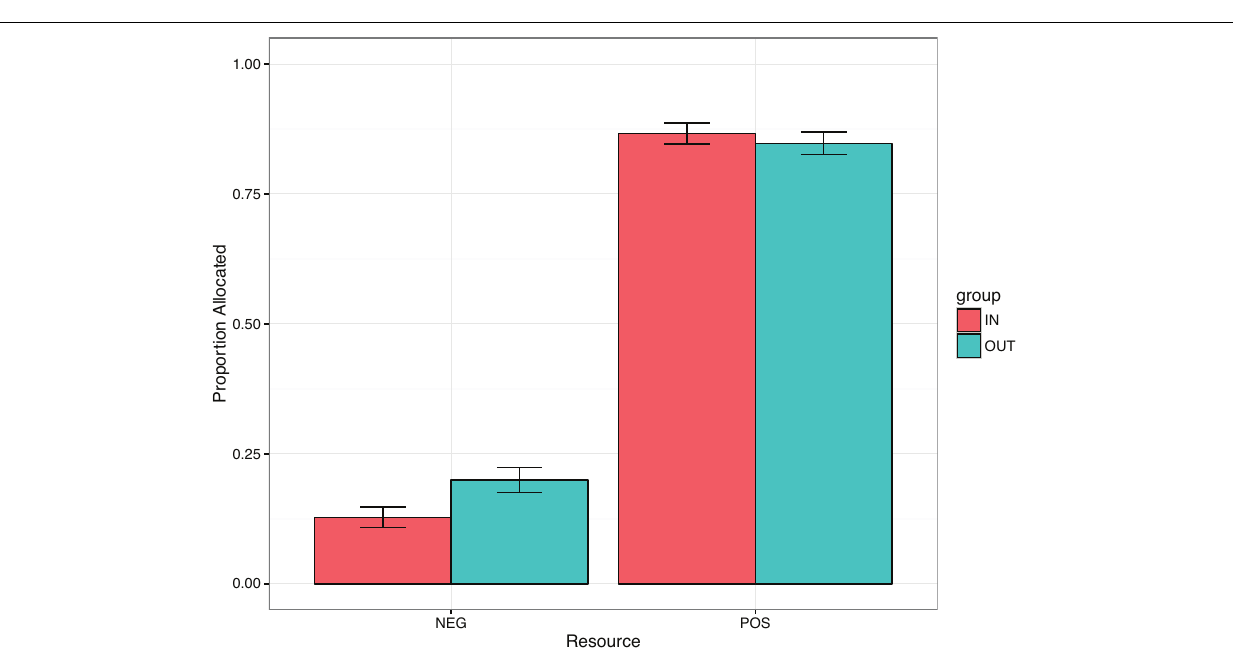
were more likely to allocate negative resources to out-group than in-group recipients, however, no group effect was observed for positive resources. Finally, this tendency to allocate negative resources to out-group recipients was largely driven by young males, we did not observe evidence of in-group bias amongst older participants or amongst females